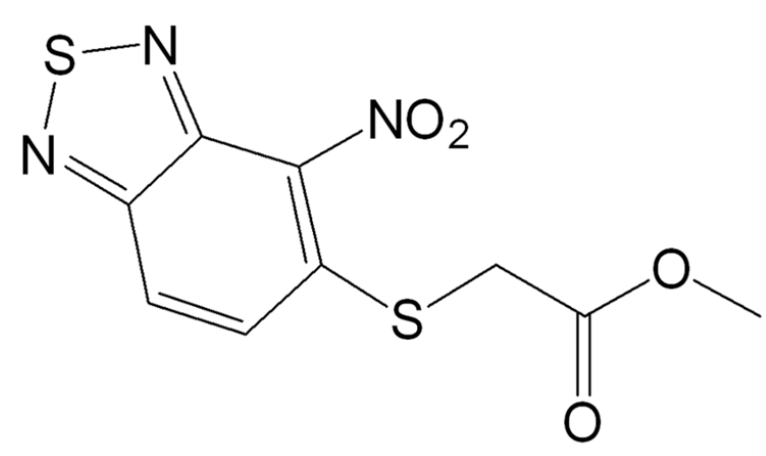
Figure 1. Chemical structure of C109 compound.